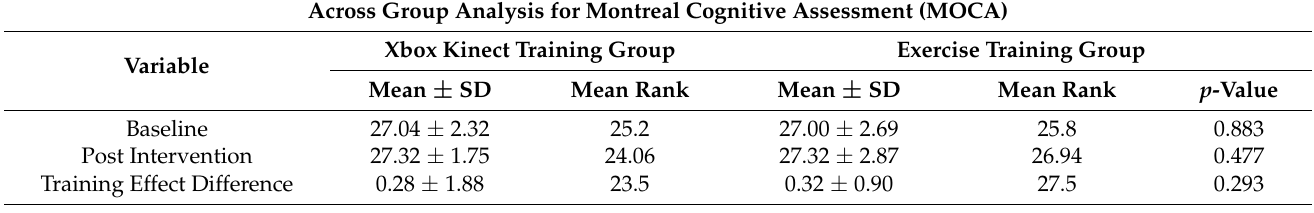
Table 5. Within- and across-group analysis for Montreal Cognitive Assessment (MOCA). Across Group Analysis for Montreal Cognitive Assessment (MOCA)